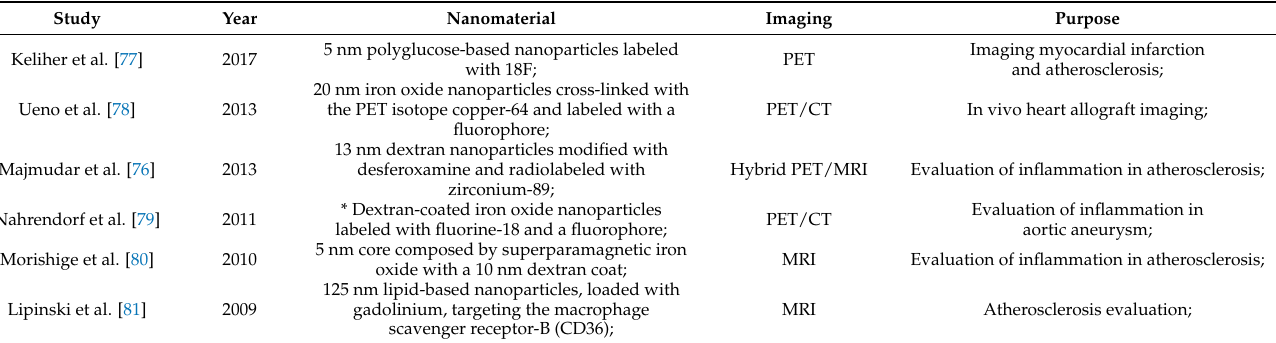
Table 3. Targeting macrophages for cardiovascular